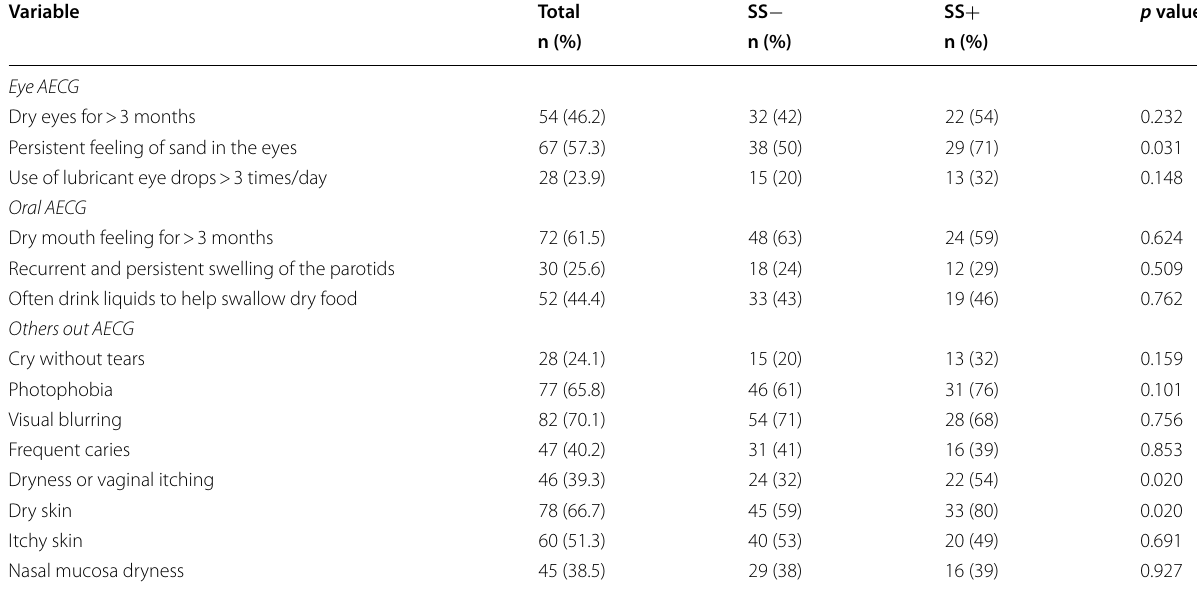
Table 2 Comparison of dryness symptoms in patients with systemic lupus erythematosus with (SS syndrome